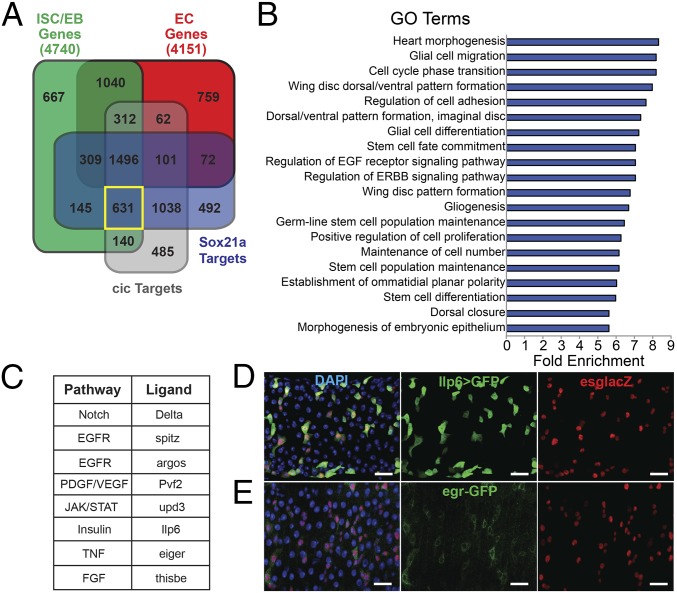
Stem/progenitor-specific TF profiling identifies ligands of major pathways. (A) Overlap of genes showing ISC/EB expression (green), EC expression (red), Sox21 binding (blue), and cic binding (gray). See Dataset S4 for gene lists. (B) GO terms enriched in the 631 genes specifically expressed in ISC/EBs and with regulatory regions bound by both Sox21a and cic. (C) Major developmental signaling pathway ligands specifically expressed in ISC/EBs and bound by both Sox21a and cic. (D) Expression of Ilp6 in ISC/EBs. DAPI (blue), EGFP driven by Ilp6-GAL4 (green), and esg-lacZ (red). (Scale bars, 20 µm.) (E) Expression of egr in ISC/EBs. DAPI (blue), egr-GFP protein trap (green), and esg-lacZ (red). (Scale bars, 20 µm.)